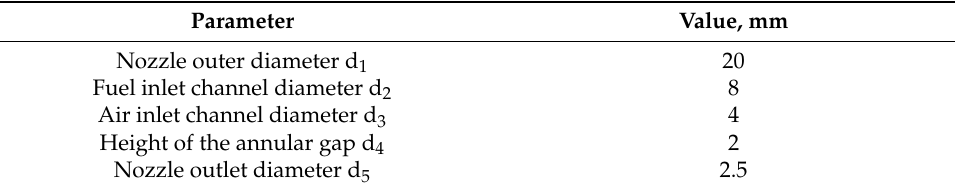
Figure 4. Scheme of the pneumatic injector. Table 1. Values of geometric